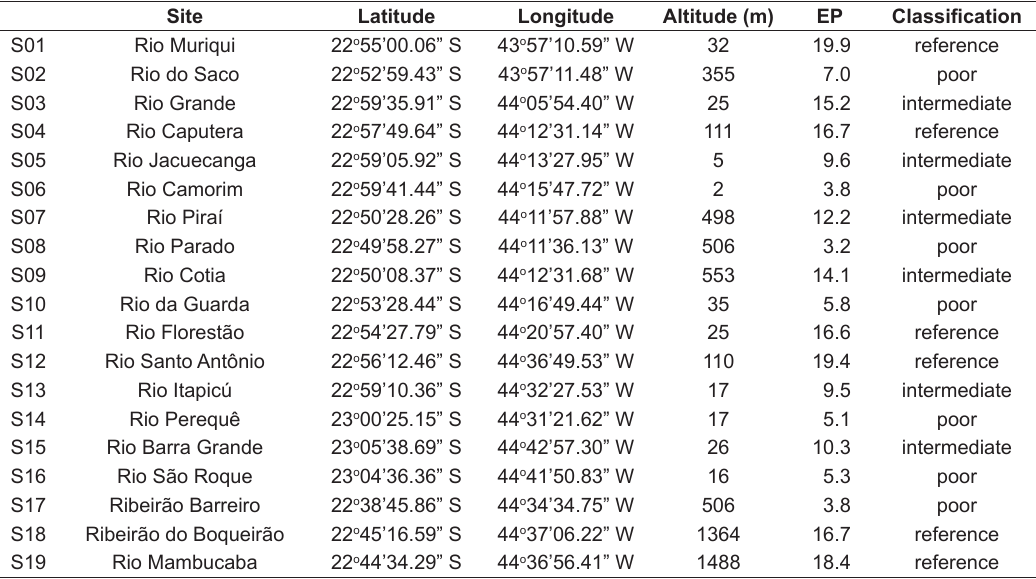
Table 1. Localization, score of Environmental Assessment Protocol (EP) and Environmental classification for each studied stream in Serra da Bocaina